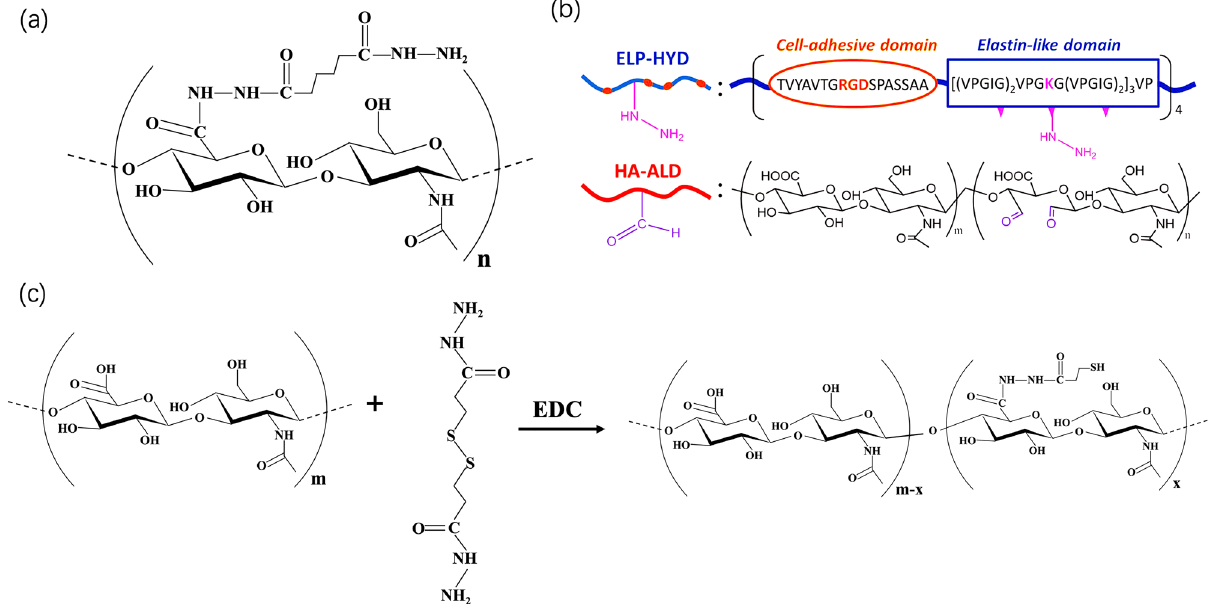
Figure 2: ( a ) The chemical structure of hydrazide - functionalized HA. ( b ) The structure of hydrazine - modi fi ed elastin - like protein and aldehyde - modi fi ed HA [ 56 ] . ( c ) Synthetic route of thiol - modi fi ed